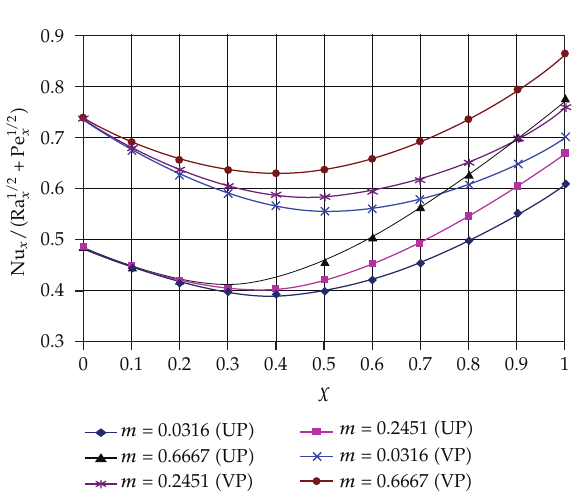
Figure 2: Comparison of values Nu x / (cid:3) Ra 1 / 2 x (cid:9) Pe 1 / 2 x (cid:6) for m and χ with R d (cid:8) 0 . 1 and H (cid:8) 1 . 1 for both UP and VP